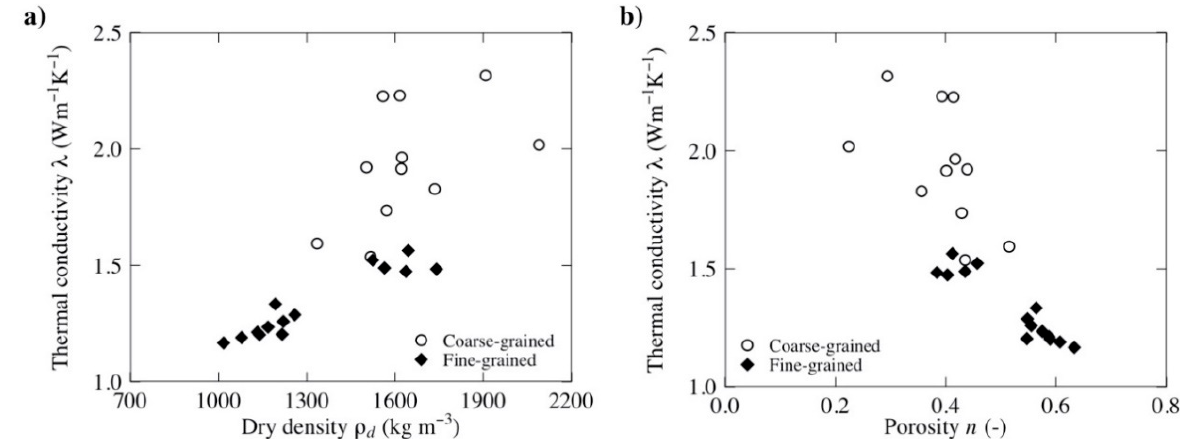
Figure 8. Effect of index properties on the thermal conductivity of the soil samples: ( a ) dry density; and ( b ) porosity.